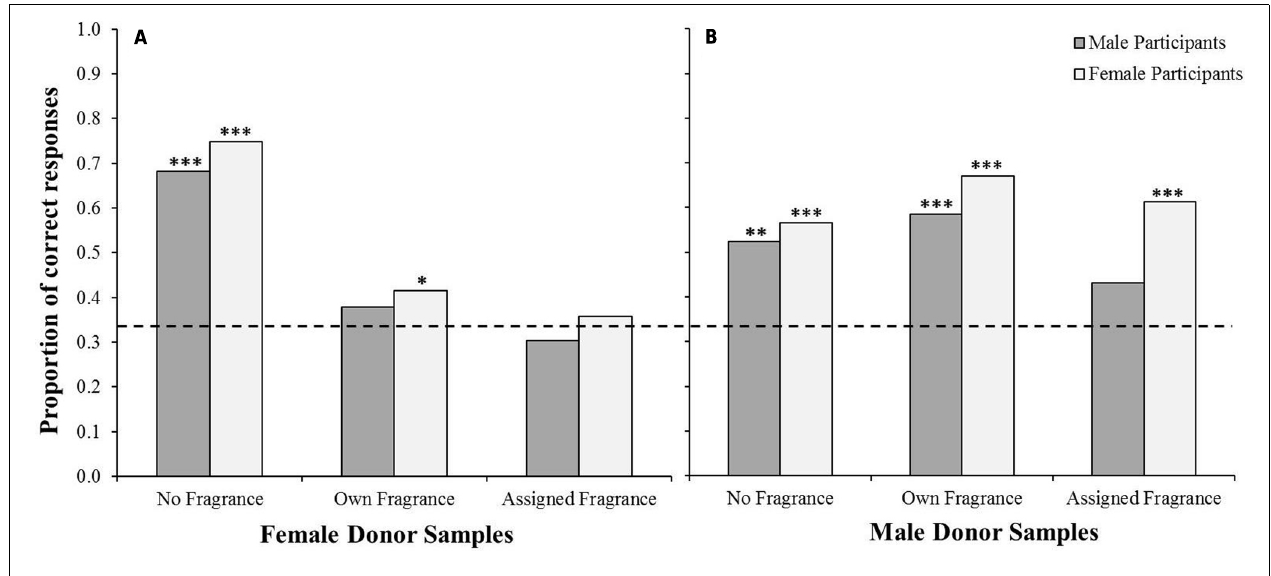
FIGURE 2 | Proportion of male and female participants who correctly chose the odd one out on the triangle test when using female samples (A) and male samples (B). Dashed line indicates the